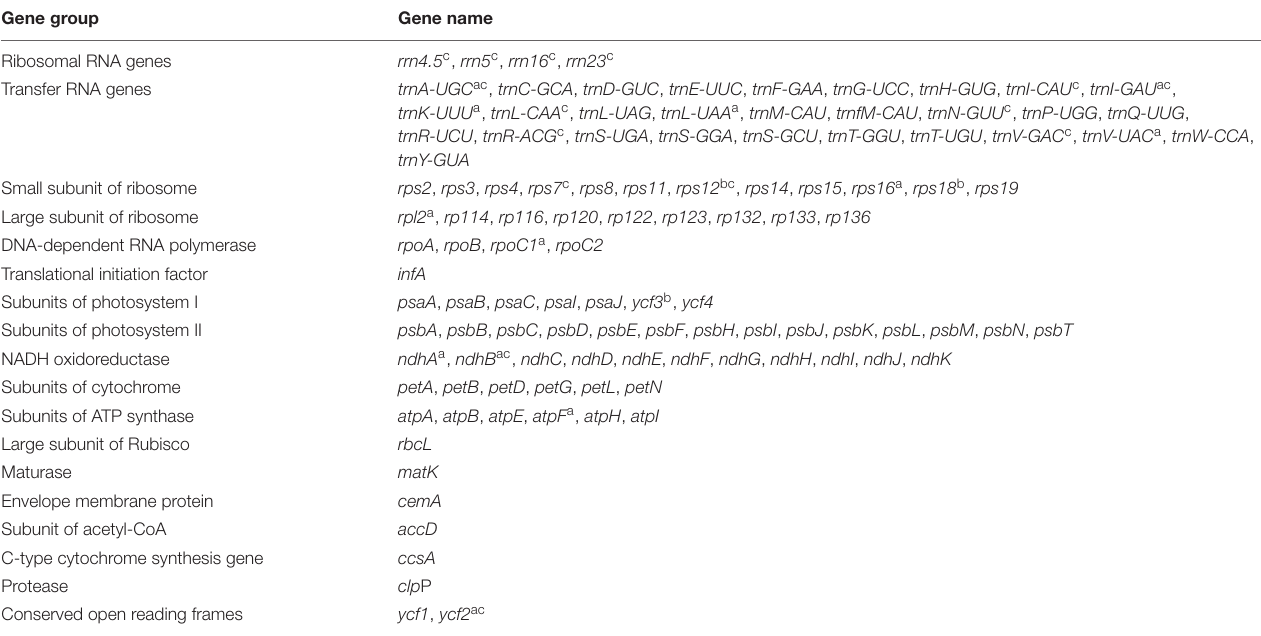
TABLE 1 | Genes in the 14 Dipelta chloroplast genomes. Gene